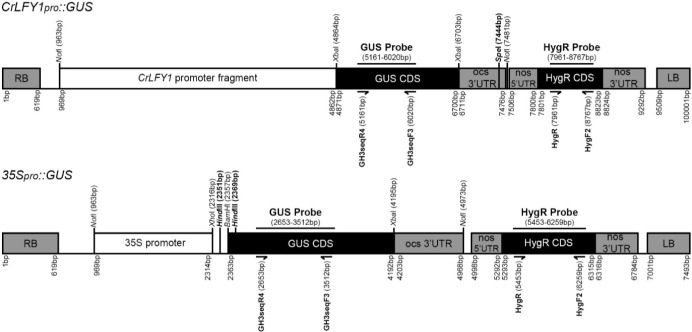
Schematic of CrLFY1pro::GUS and 35Spro::GUS constructs.Hybridization probes for the GUS and hygromycin resistance (HygR) genes, plus the position of the SpeI and HindIII restriction sites used for DNA gel blot analysis (Figure 4—figure supplement 2) are indicated. Restriction sites used in plasmid construction (see Materials and methods) are also indicated. All nucleotide positions are given relative to the start of the T-DNA right border (RB). Primer sequences are listed in the Key Resources Table.